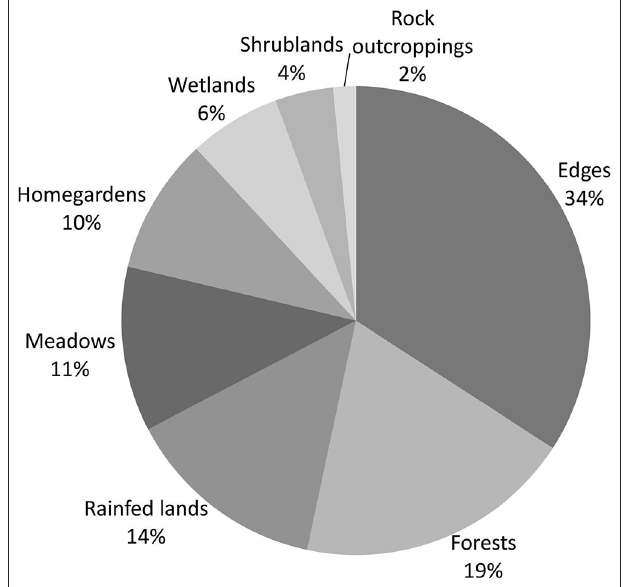
FIGURE 6 | Percentage of use-reports related to the habitat where wild food species grow in Sierra Norte de